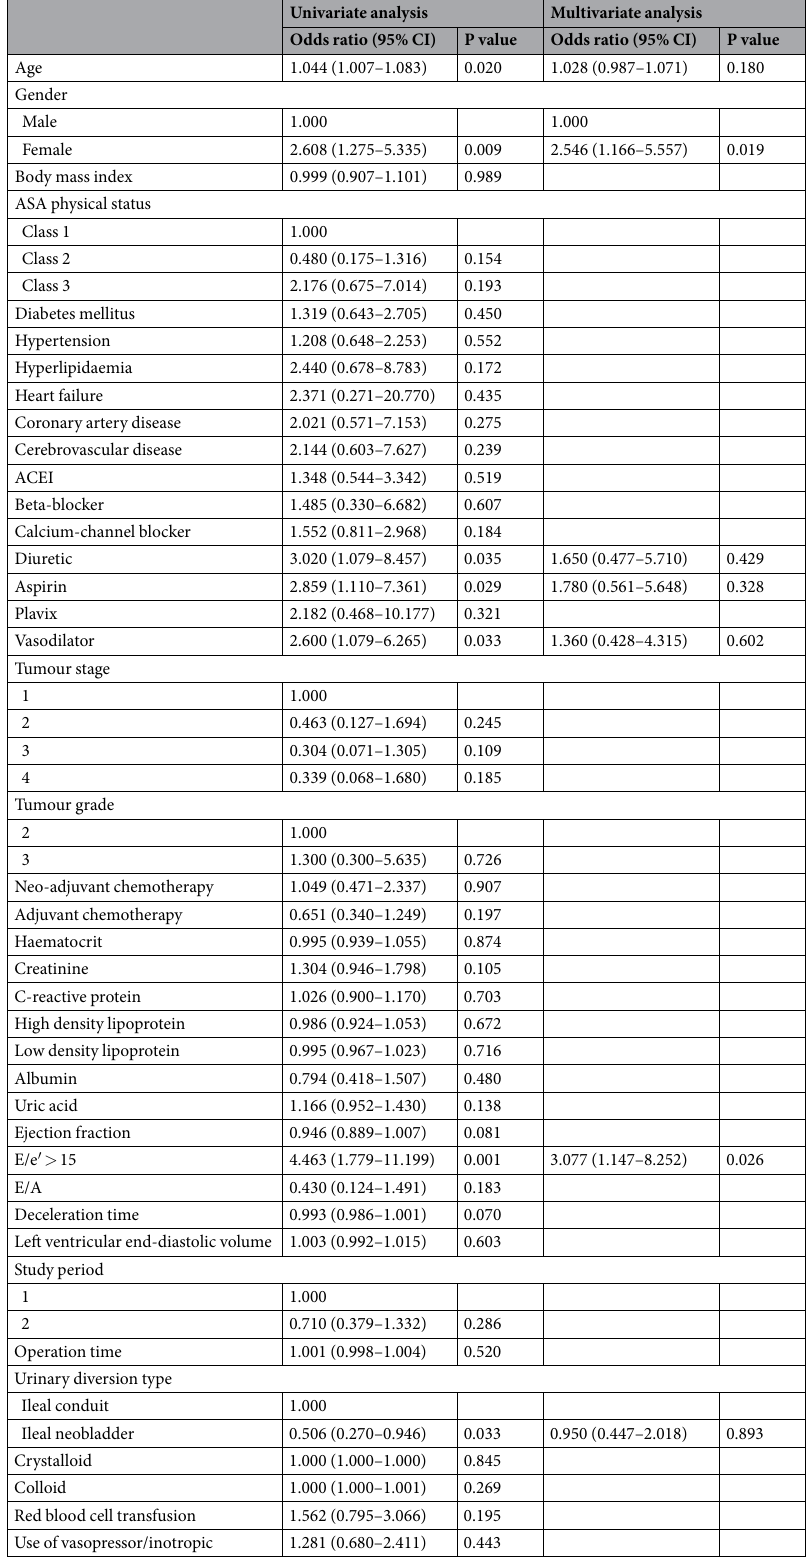
Table 3. Univariate and multivariate regression analyses to identify factors that associate with MACE within 6 months after radical cystectomy. MACE = major adverse cardiac events; CI = confidence interval; ASA = American Society of Anesthesiologist; ACEI = angiotensin-converting enzyme inhibitor; E/e ′ = early transmitral filling velocity/ early diastolic septal mitral annulus velocity, E/A = early transmitral filling velocity/late transmitral filling velocity. Years 2005 to 2010 were classified as period 1 and years 2011 to 2016 were classified as period